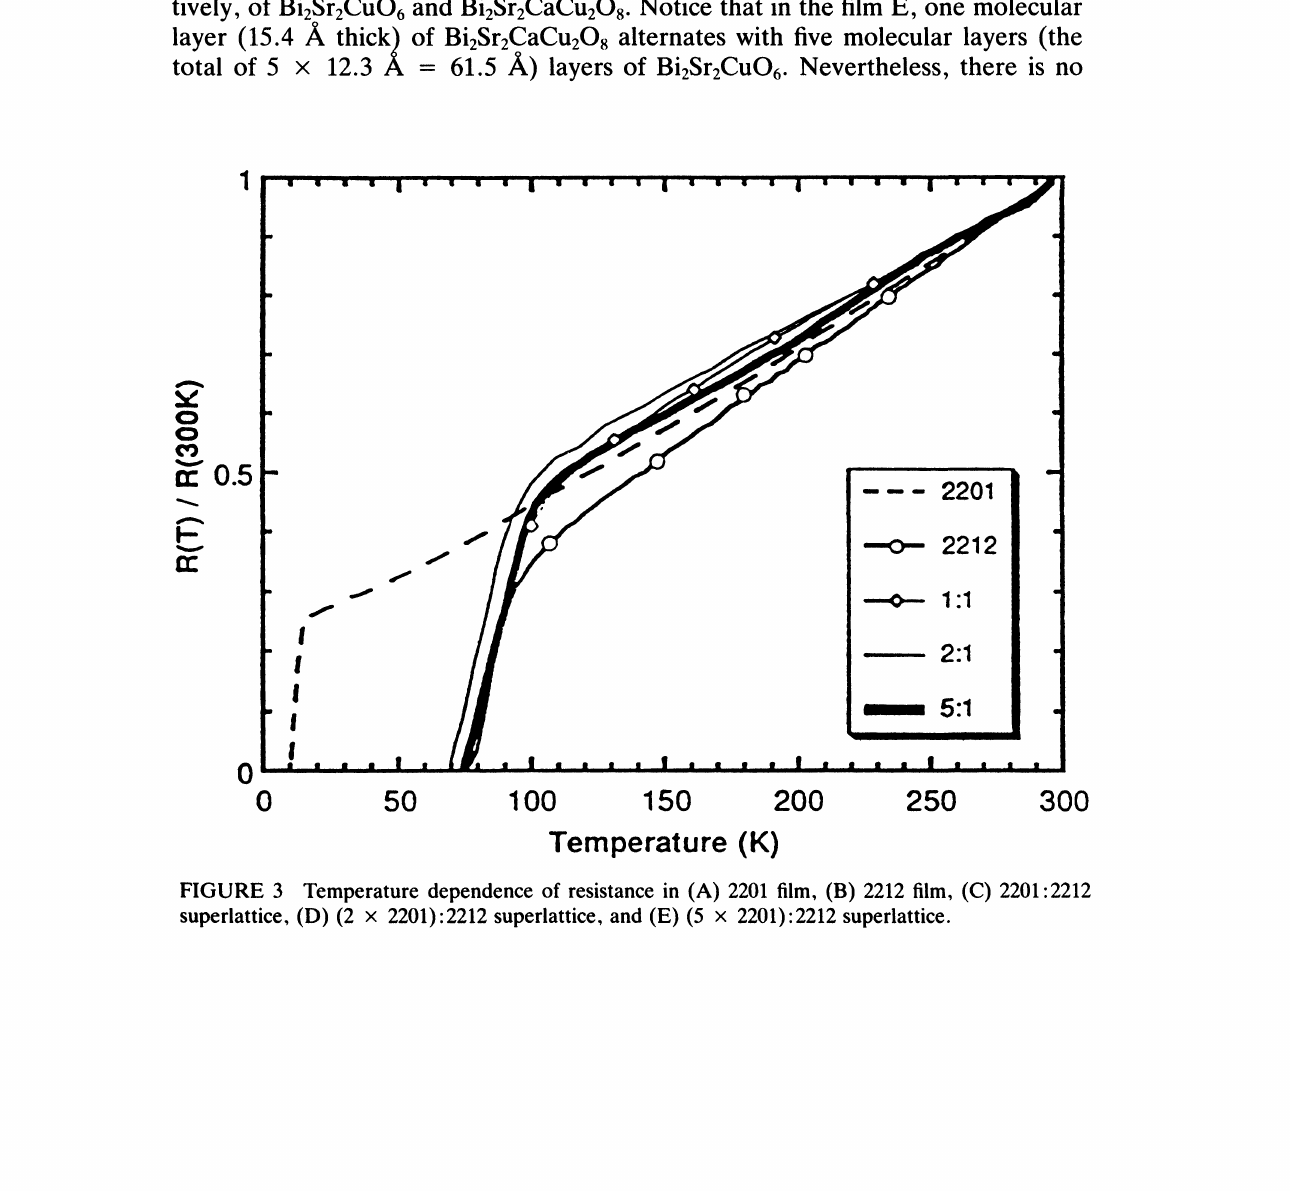
FIGURE 3 Temperature dependence of resistance in (A) 2201 film, (B) 2212 film, (C) 2201:2212 superlattice, (D) (2 x 2201)’2212 superlattice, and (E) (5 x 2201):2212